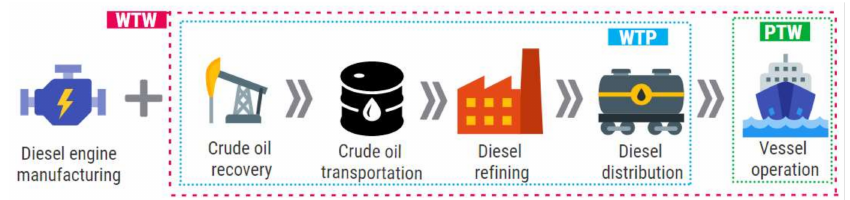
Figure 2. The life-cycle of the diesel engine-powered ship